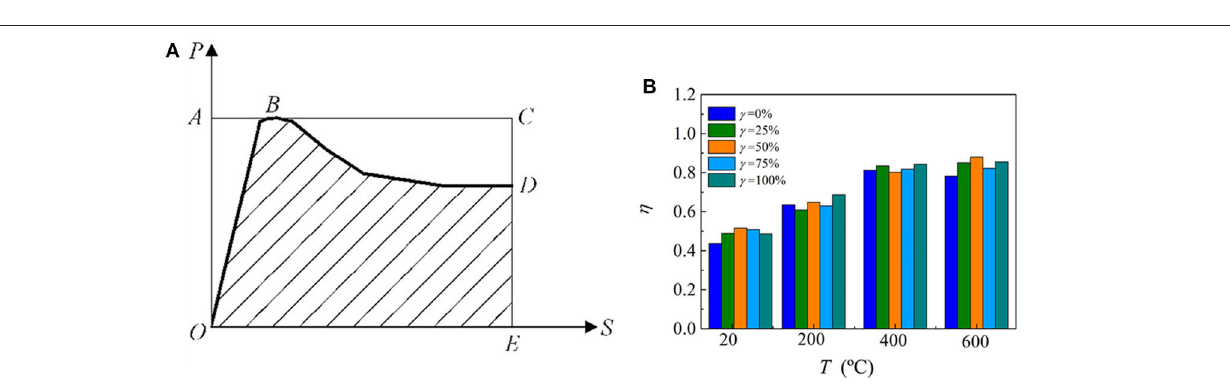
FIGURE 12 | Interfacial energy dissipation: (A) energy dissipation area; (B) energy dissipation